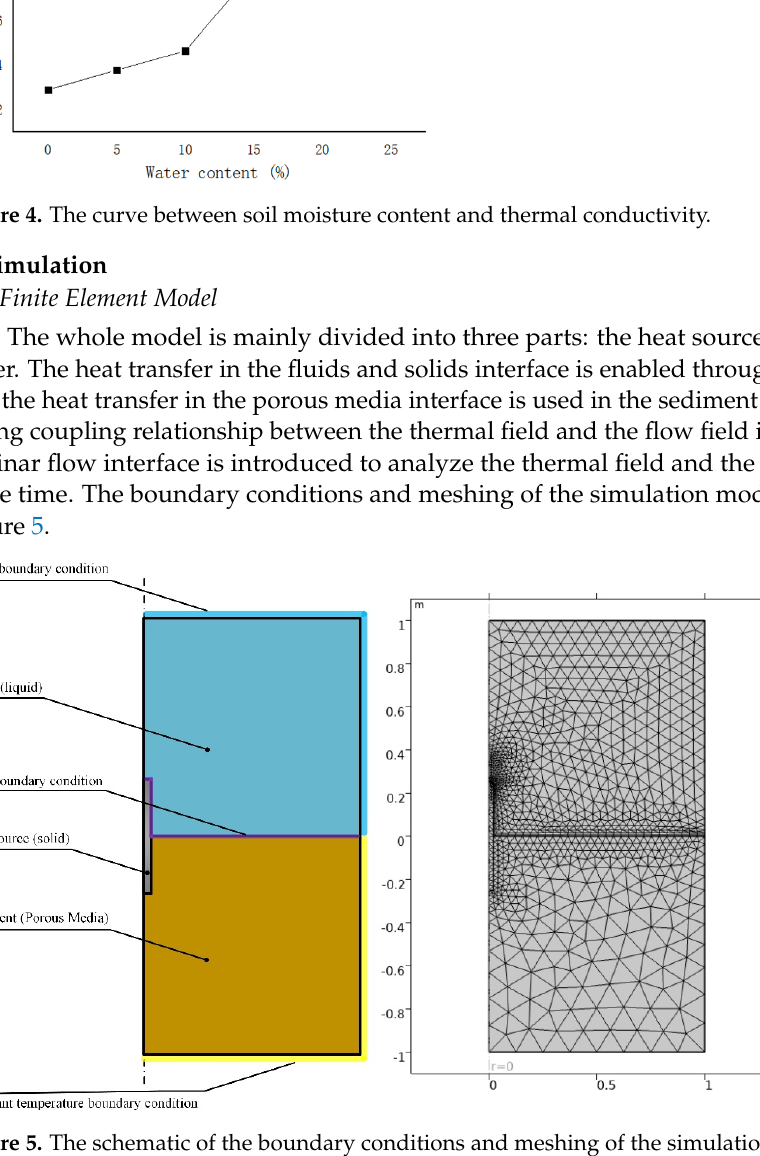
Figure 4. The curve between soil moisture content and thermal conductivity.